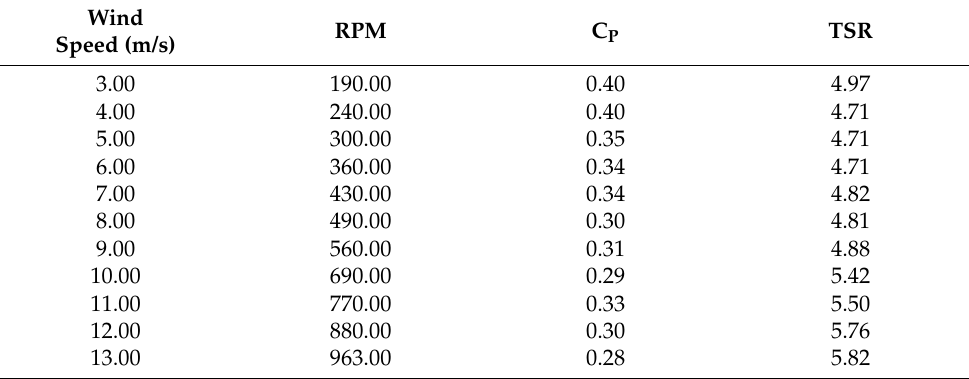
Table 4. C P -TSR characteristic curve for the 3-bladed downwind turbine configuration derived from wind tunnel test.